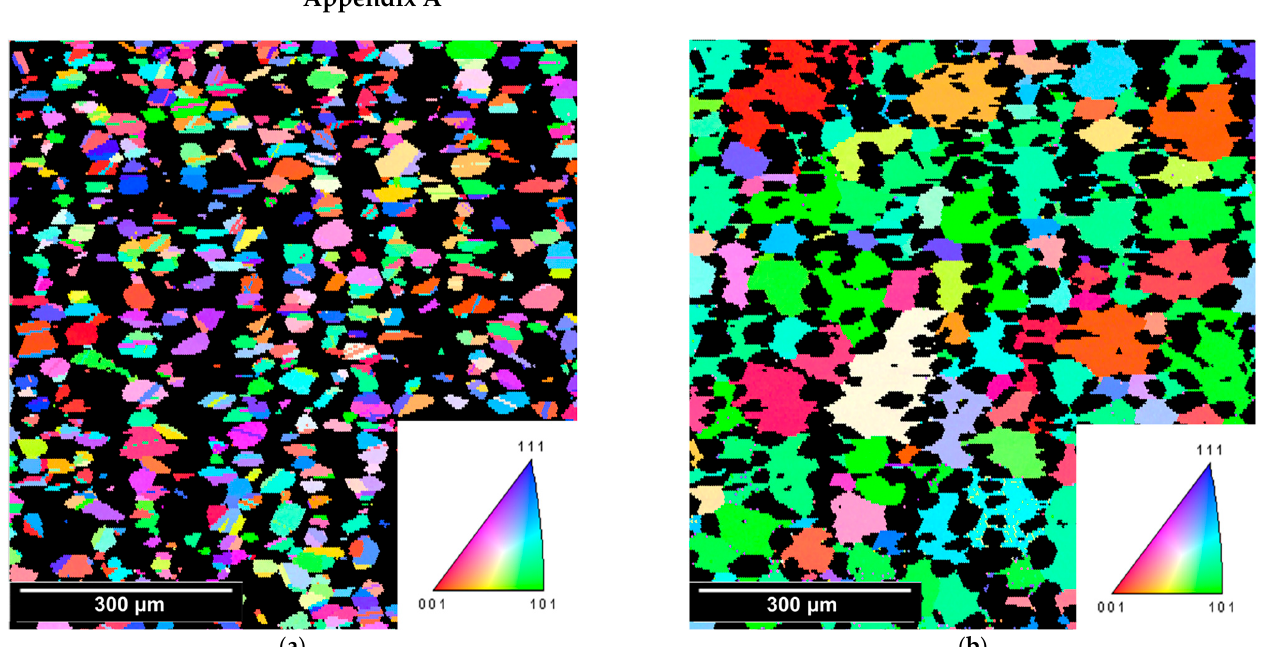
Figure A1. EBSD Crystallographic orientation—inverse pole figure coloring map for austenite ( a ) and ferrite ( b ) of the hot-rolled DSS X2CrNIMoN22-5-3 after heat treatment.